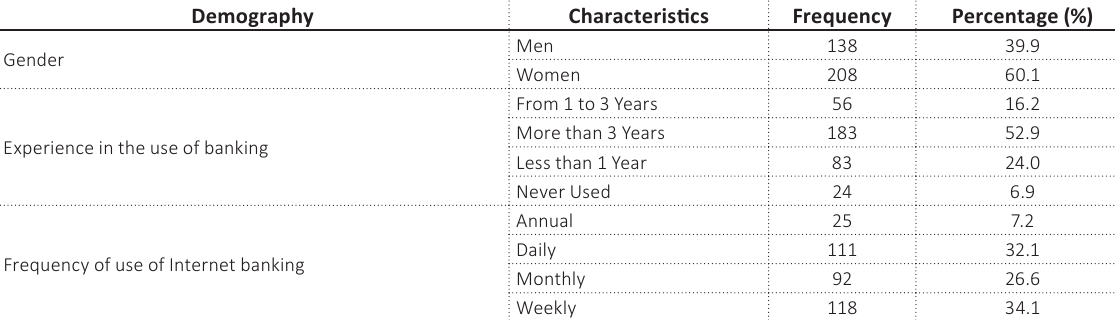
Table 2. Demographic